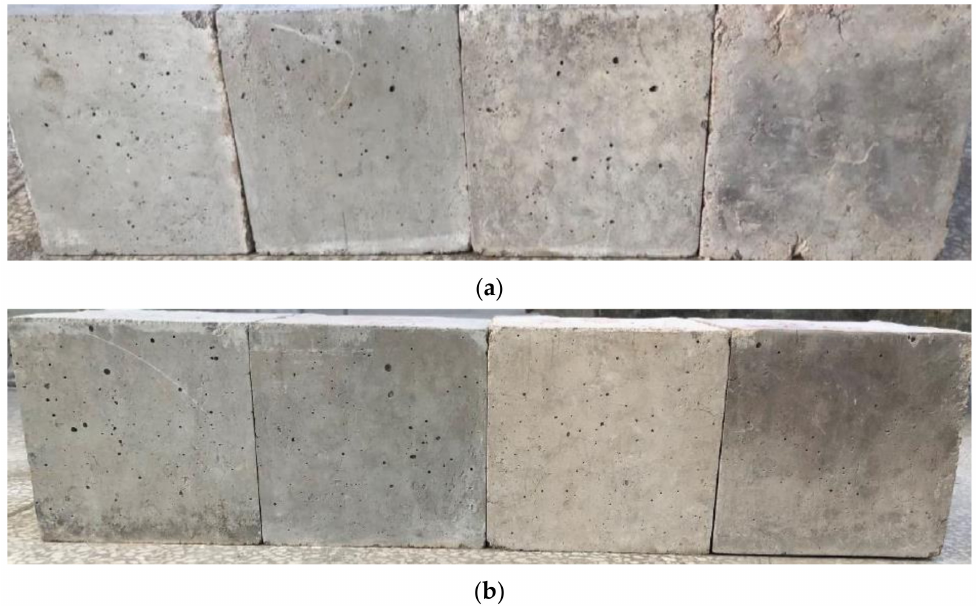
Figure 12. Comparison of RAC specimens at 20 ◦ C, 200 ◦ C, 400 ◦ C and 600 ◦ C [114]: ( a ) RAC specimen without fiber; ( b ) RAC specimen incorporating